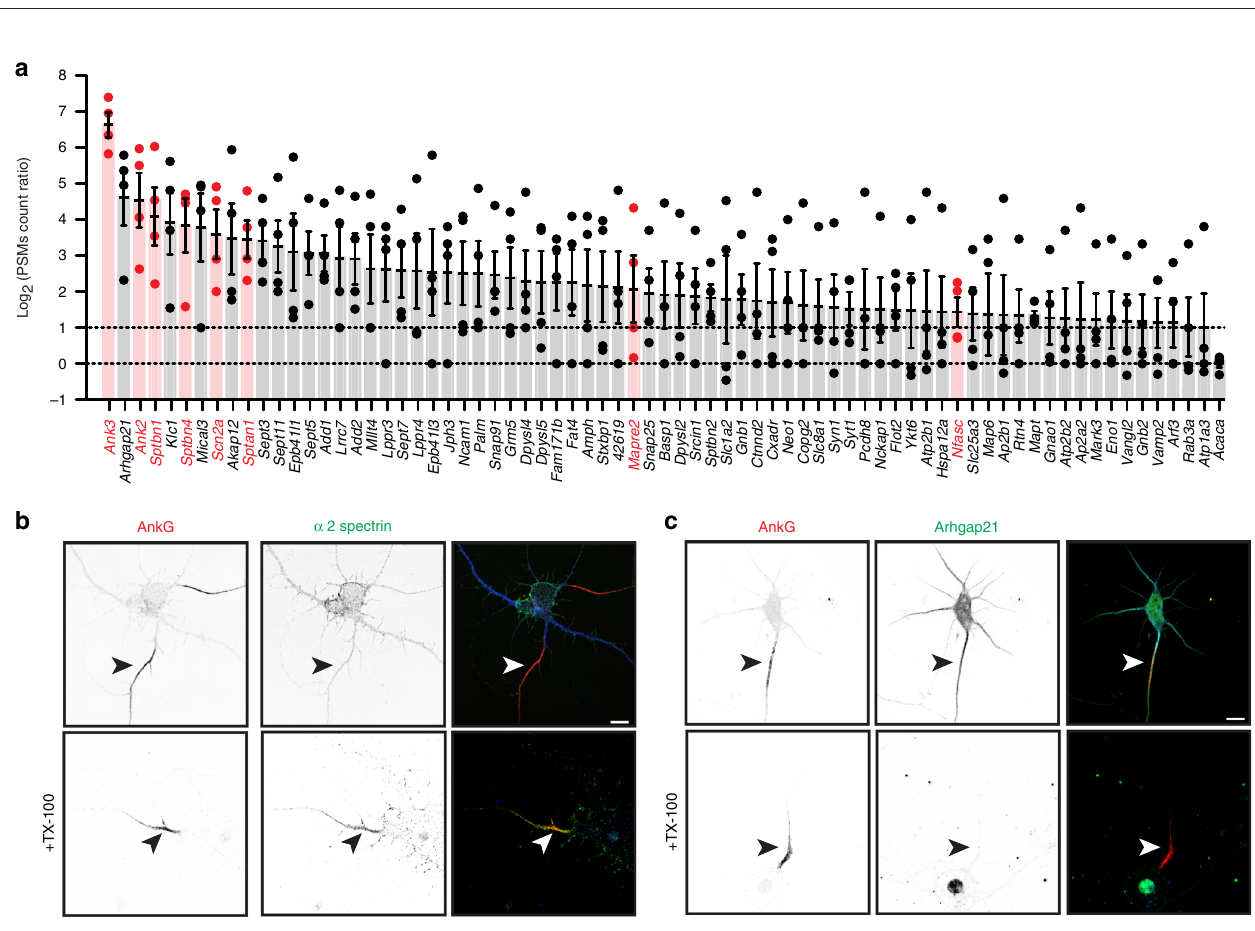
Fig. 1 Proximity biotinylation using NF186-BirA* reveals AIS-associated proteins. a The experimental strategy using BirA*-dependent proximity biotinylation to identify AIS proteins. b Immunolabeling of DIV14 hippocampal neurons transduced at DIV11 using adenovirus to express HA-tagged NF186- BirA* and NF186 Δ FIGQY-BirA*. From DIV13, neuronal culture media included 50 μ M biotin. AIS (arrowheads) are labeled using antibodies against β 4 spectrin (blue). The NF186-BirA* and NF186 Δ FIGQY-BirA* chimeras are labeled using anti-HA antibodies (red). Biotinylated proteins were detected using Alexa488-conjugated Streptavidin. Scale bar = 5 μ m. c , d The number of peptide spectral matches (PSMs) for each biotinylated protein identi fi ed by mass spectrometry and shown at different scales. Known AIS and NF186-interacting proteins are indicated in red. The solid line is the least-squares fi t of the biotinylated proteins while the dotted lines parallel to the least-squares fi t line represent an arbitrary minimum of ten PSMs con fi dence interval. PSMs are the average PSM counts for two independent replicates for each chimera. e Rank plot showing the enrichment of NF186-BirA* PSMs over NF186 Δ FIGQY-BirA* PSMs. f Protein interaction network generated using Cytoscape and the STRING database of protein interactions. With the exception of Nfasc, the size of each circle is proportional to the ratio of the PSMs count for each protein indicated. White circles include proteins with no previously reported function at the AIS. Yellow circles correspond to the ankyrin/spectrin network, and red circles correspond to the septin network.